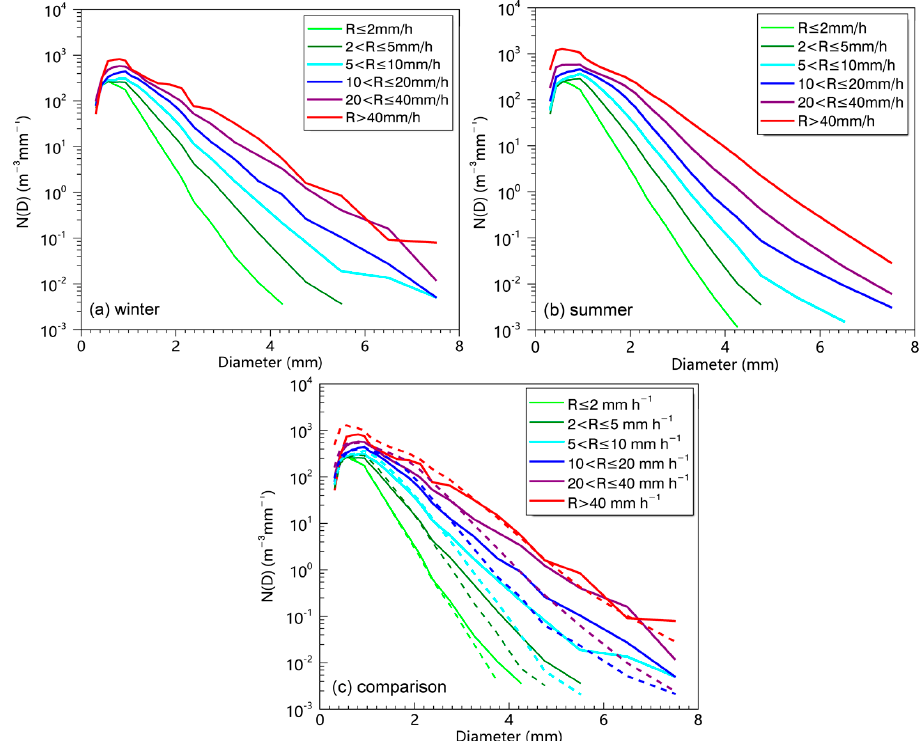
Figure 7. The average DSDs from the Parsivel disdrometer data at six indicated rain rate classes in two seasons, as well as their comparison result, where dotted lines represent summer rainfall and solid lines represent winter rainfall.